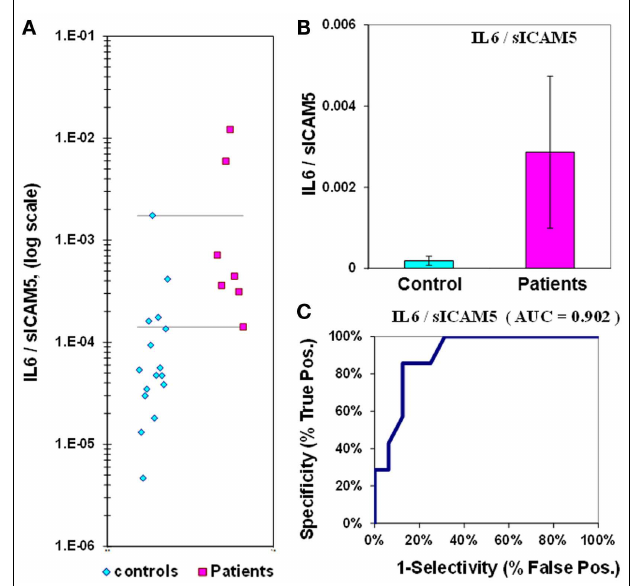
FIGURE 3 | IL-6/sICAM5 ratio in plasma from epilepsy patients and controls. (A) Dot-plot of IL-6/sICAM5 concentrations in plasma (square, patients; diamond, controls). For values between the horizontal lines, the assay does not accurately discriminate between patients and controls. (B) Bar graph and error calculation for data in Part (A) . Difference is not significant, with p = 0.087. (C) ROC curve for data in Part (A) , showing an area under the curve (AUC) value of